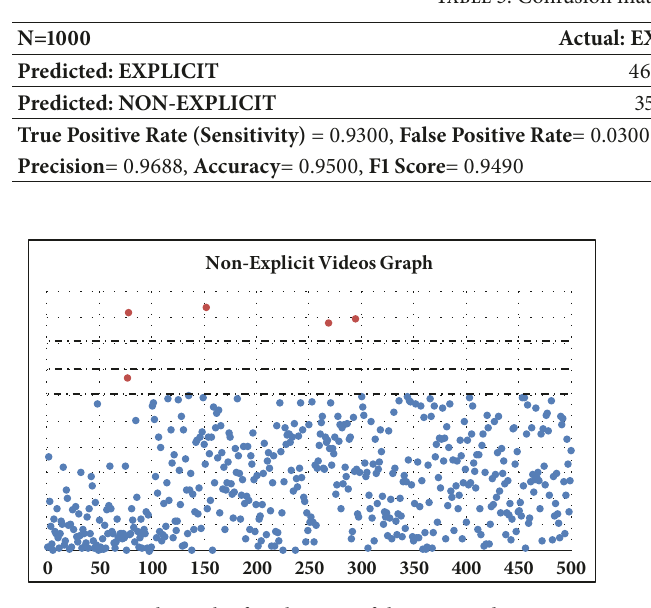
Figure 15: Result graph of application of the proposed ECD system on 500-nonexplicit video dataset.